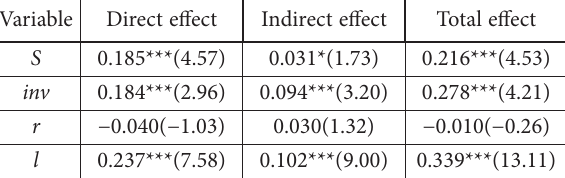
Table 7. The direct, indirect, and total effects of the whole